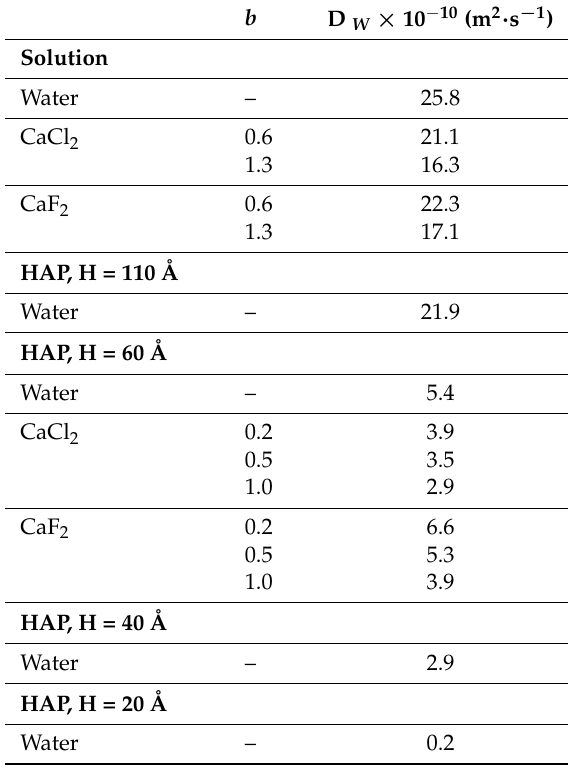
Table 3. The self-diffusion coefficient (D W ) for bulk and confined water. Concentration of CaCl 2 and CaF 2 in mol · kg − 1 ( b